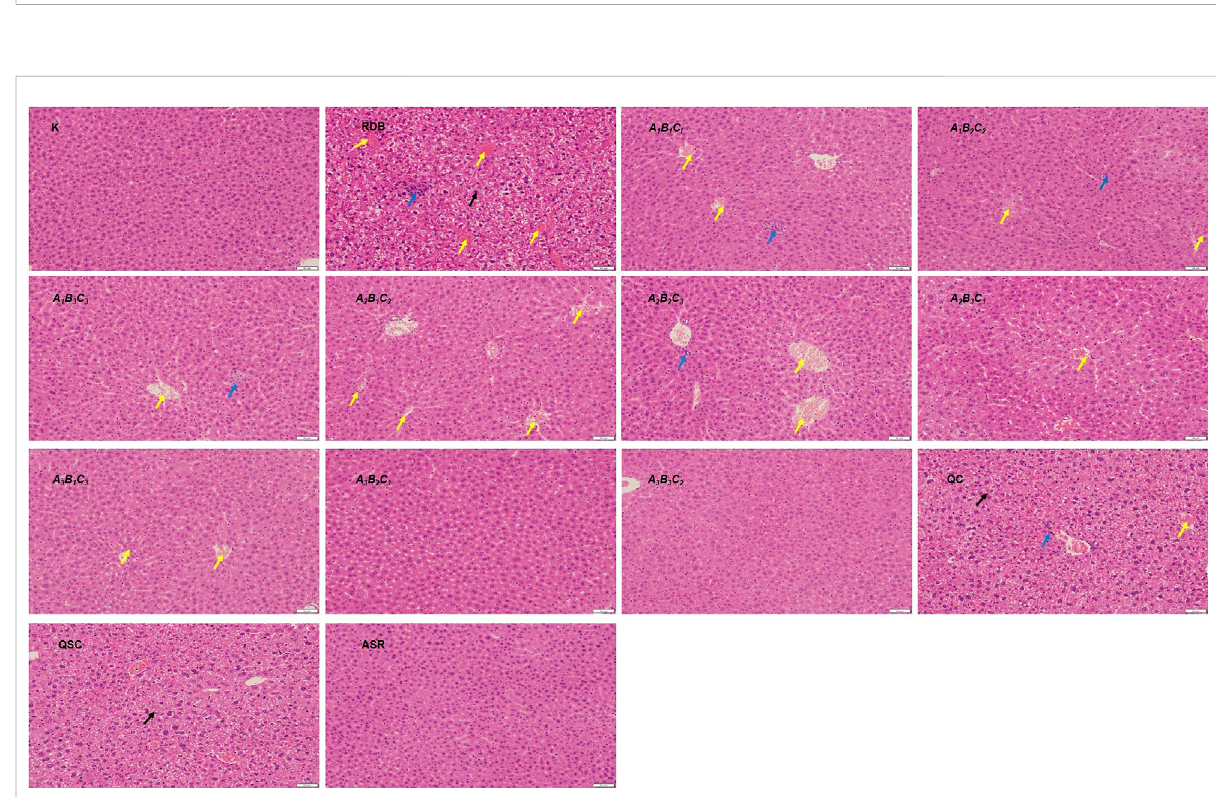
FIGURE 3 Processing with ASR improved the liver cell degeneration, cytoplasmic looseness, hepatocyte edema, in fl ammatory in fi ltration, and vascular congestion induced by RDB. HE staining (original magni fi cations, ×200) of liver tissues. (Black arrows indicated cytoplasmic looseness, blue arrows indicated in fl ammatory in fi ltration, and yellow arrows indicated vascular